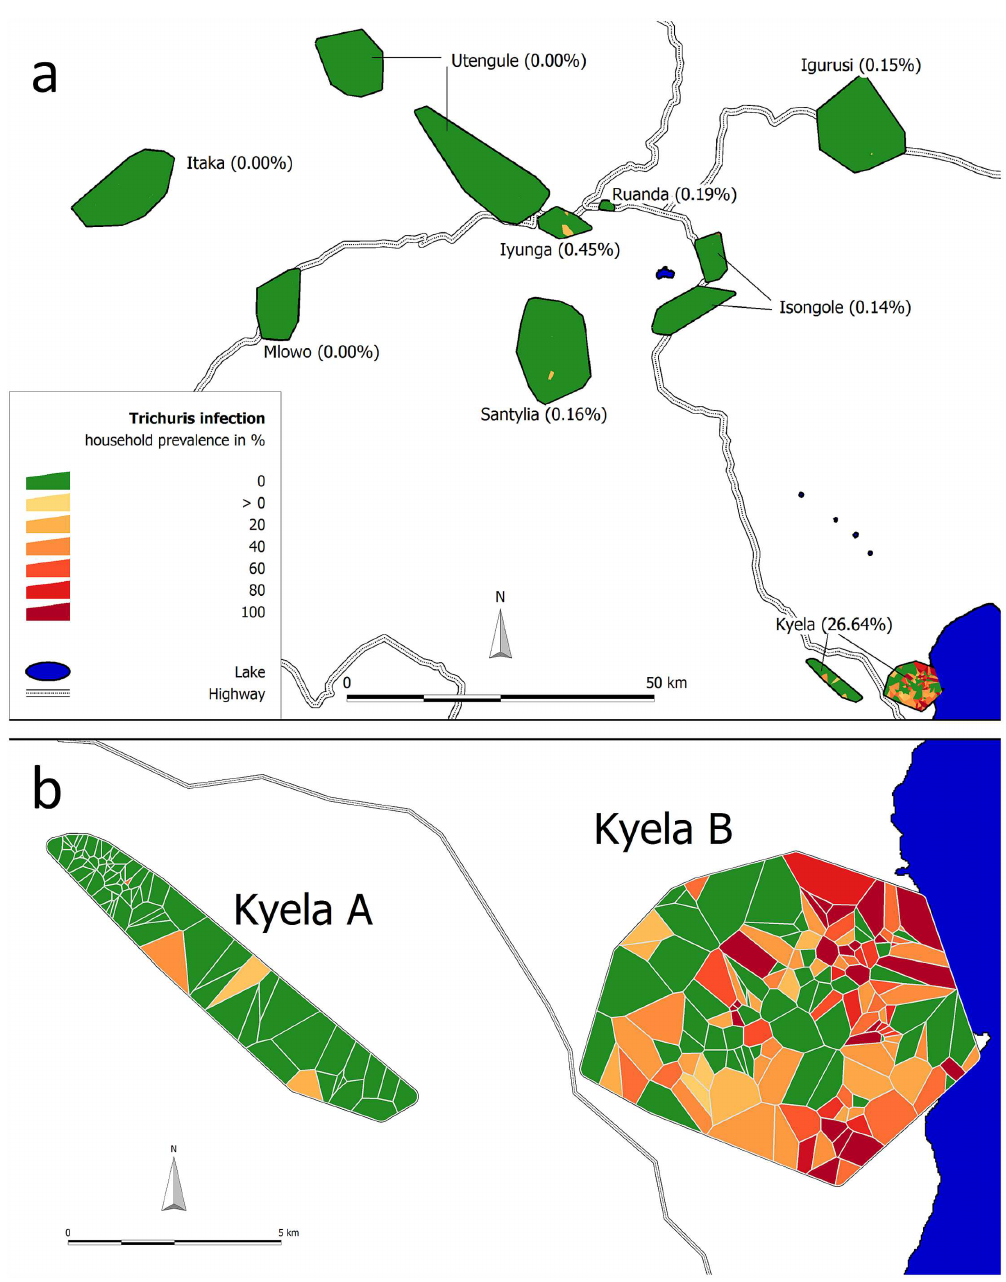
Fig 2. Prevalence of T . trichiura infection in the nine EMINI study sites in Mbeya region, Tanzania (A) and details for Kyela site (B). Householdswith at least one infected person are representedby red Voronoipolygons, householdswithout are shown in green. Subsite A and B in this text refer to the western and eastern part of Kyela, respectively.